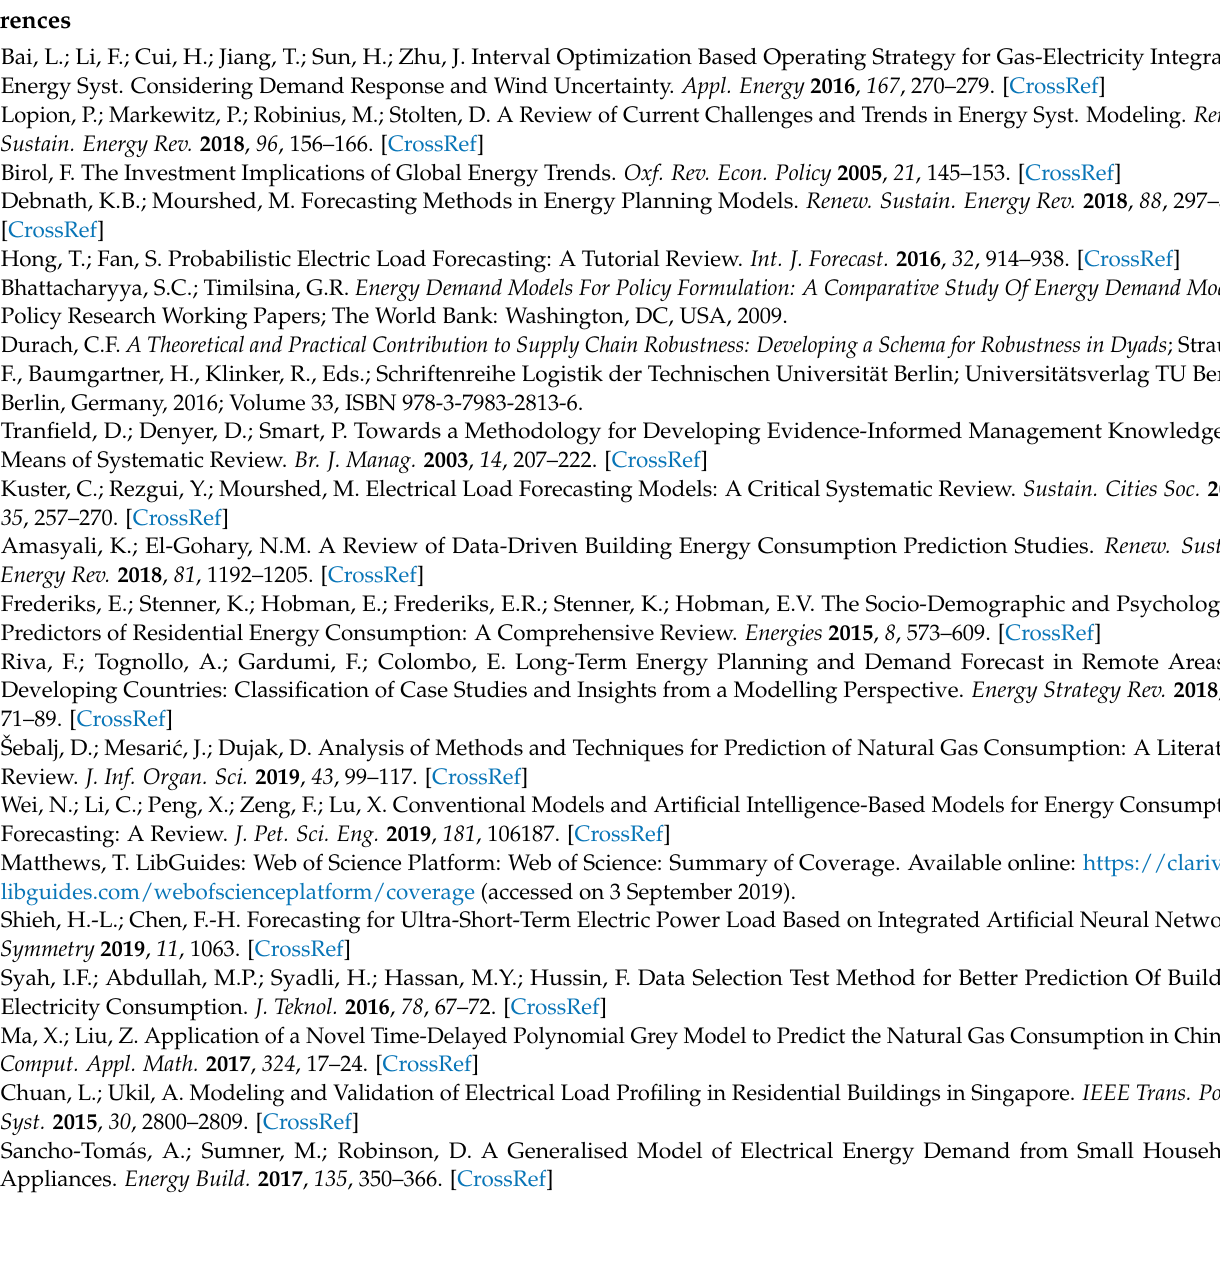
Figure A3. Technical systems analyzed. This shows that most articles focus on power grids and